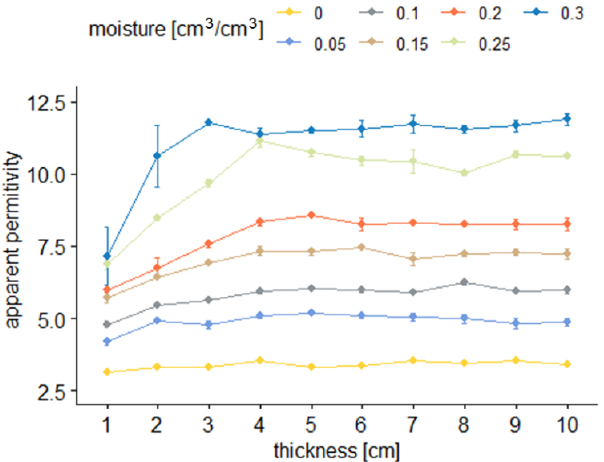
Figure 6. Average apparent permittivity readouts with sensor A depending on sample thickness for the particular material moisture.